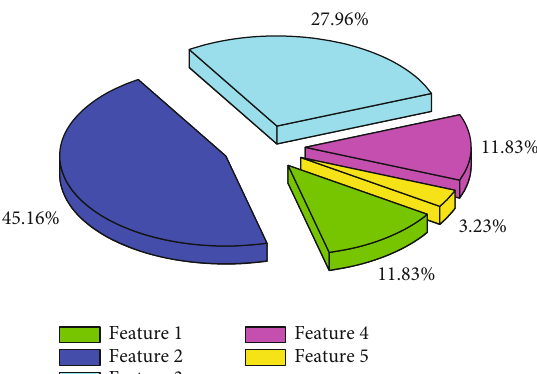
Figure 3: Attribute distribution diagram of clothing pro fi le feature coe ffi